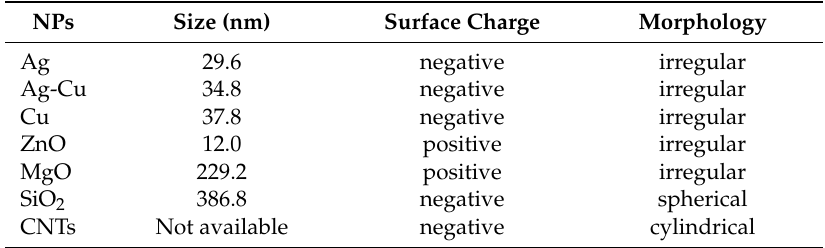
Table 6. Sizes, morphologies, and surface charges of the